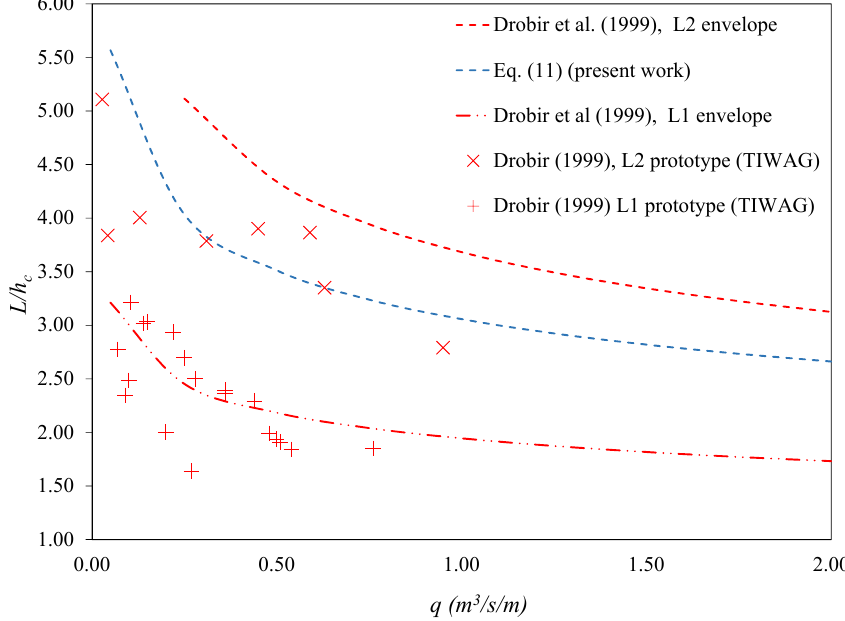
Figure 26. Comparison of adjusted wetted rack lengths L , L 1 and L 2 envelopes dimensionless with critical depth, as a function of the incoming flow for circular bars with m = 0.60 and longitudinal slope of 20%.